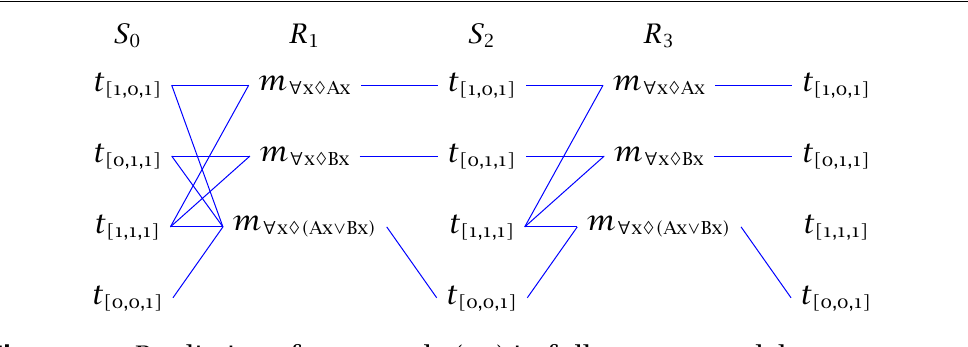
Figure 17 Predictions for example ( 99 ) in full context